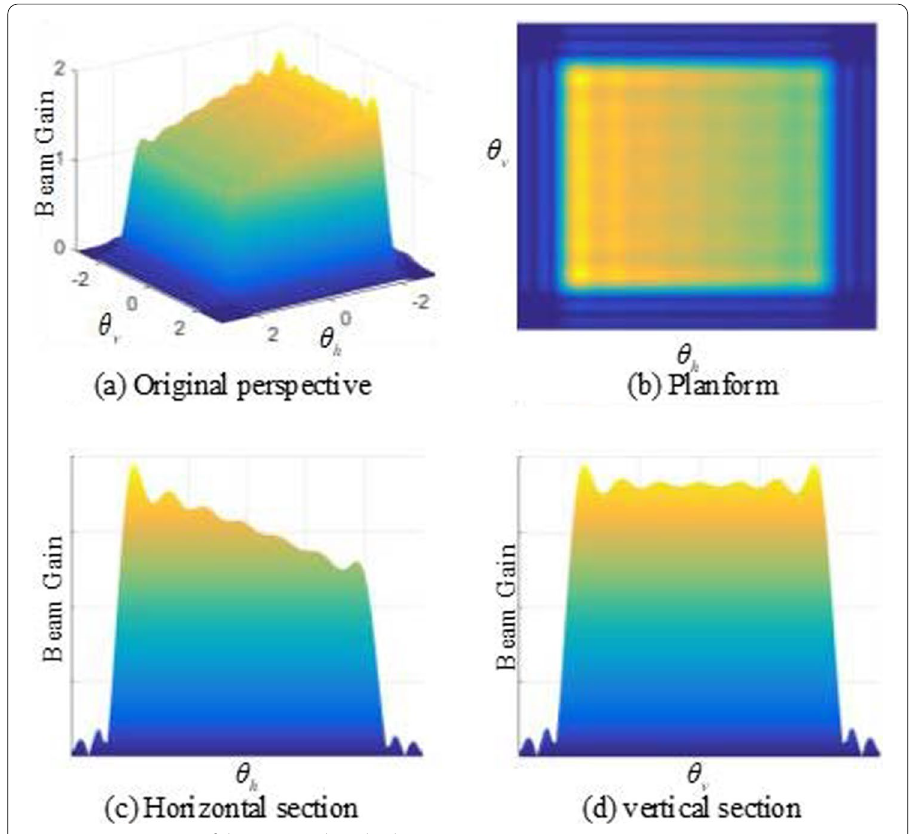
Fig. 6 Beam patterns of the proposed